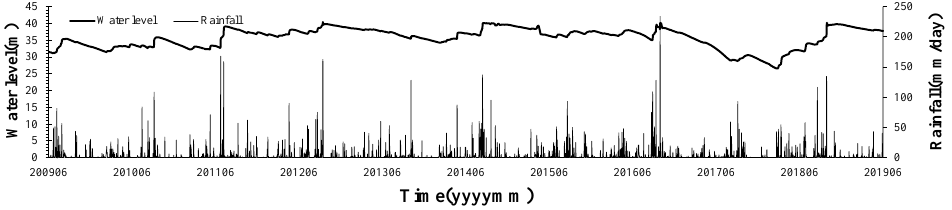
Figure 3. Water level and rainfall.